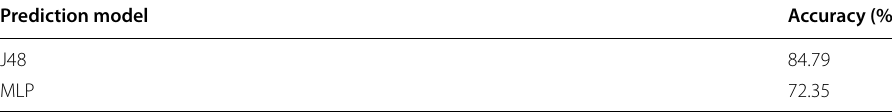
Table 13 Prediction model summary for attributes